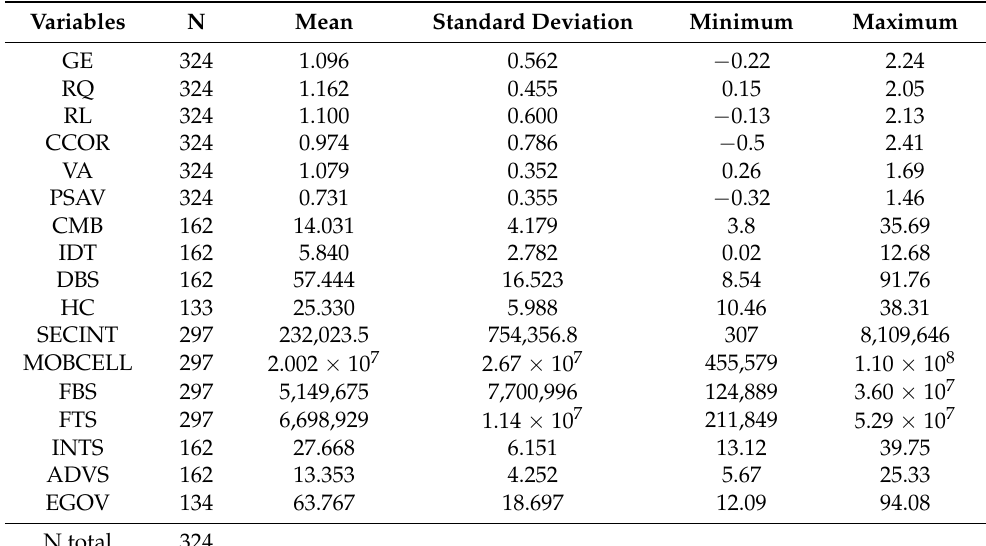
Table 3. Descriptive statistics of the variables used in the empirical analysis, compiled at the level of the EU-27 MSs, for the 2010–2021